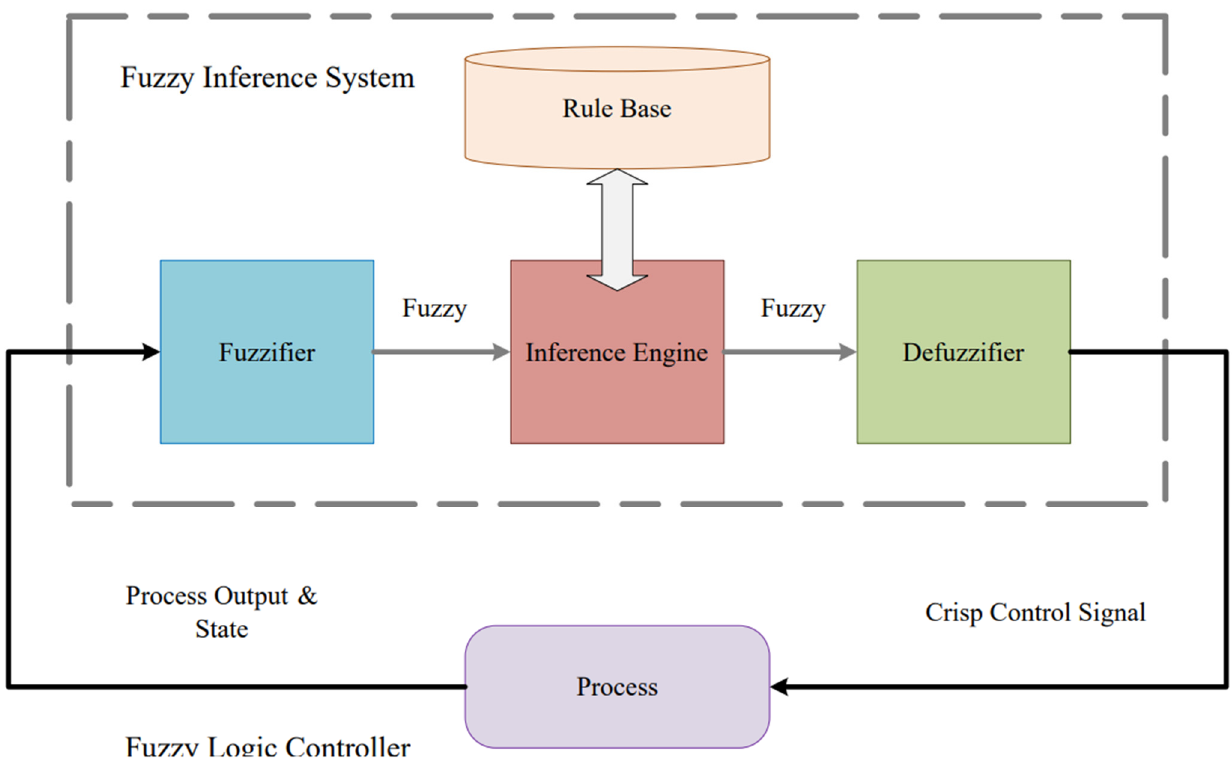
Figure 2. Fuzzy Inference System